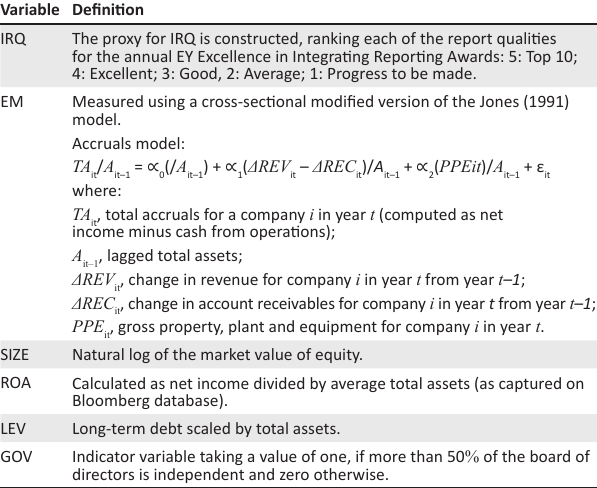
TABLE 1-A1: Summary of variable